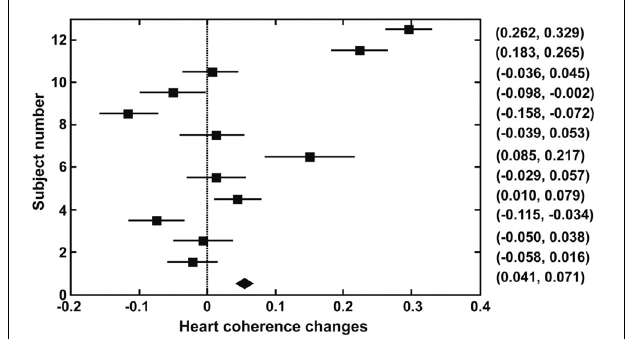
FIGURE 1 | Confidence intervals (95%) for changes in heart coherence from baseline to during meditation in each participant and for all participants combined (bottom indicates the result for all participants).